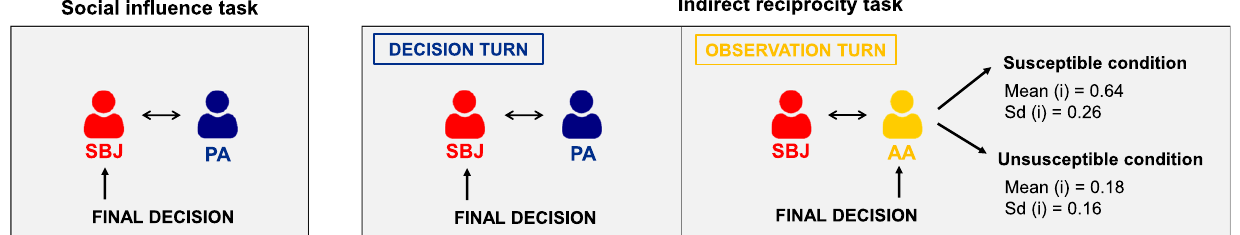
Figure 2. ( a ) Experimental task. In both the Social influence and the Indirect reciprocity task, initially participants had to produce perceptual estimates by reproducing the length of visual stimuli. They saw two consecutive light flashes (i.e., red disks) and had to touch a point, to the right of the second disk, in order to reproduce the stimulus length (s), defined as the distance between the first and the second disk. Participants were told that the very same stimuli would be presented to an alleged partner (other agent: OA) who would choose a point to reproduce the same distance. After the participants’ estimate, the other agent’s